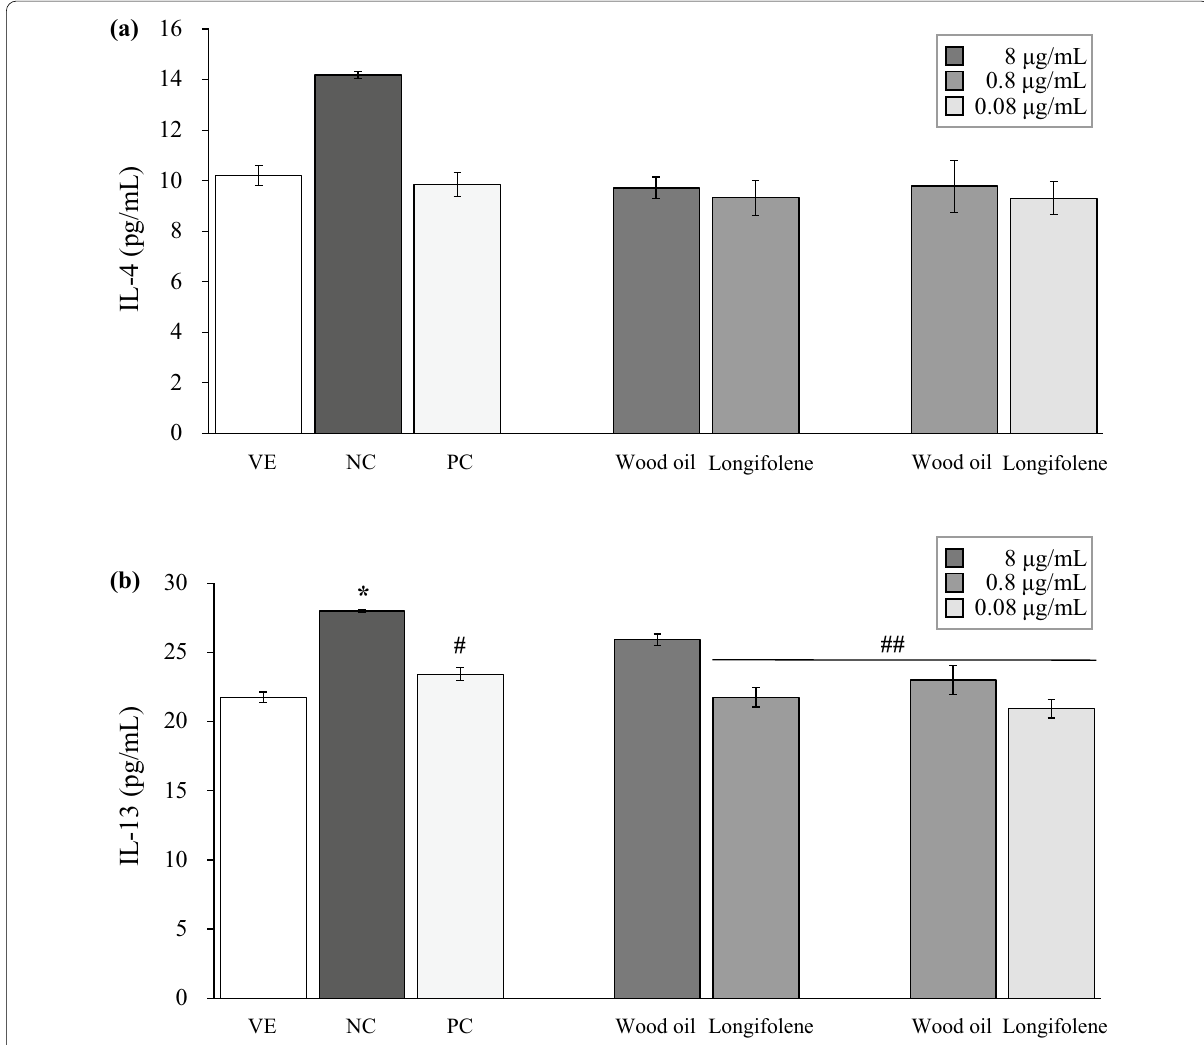
Fig. 9 Effect of longifolene on the protein expression levels of a IL‑4 and b IL‑13 in LPS‑stimulated RBL‑2H3 cells. VE: vehicle, DMSO; NC: negative control, 1 μg/mL LPS‑treated group; PC: positive control, 100 nM dexamethasone treated group. Values are presented as mean * p < 0.05 and ** p < 0.01 compared with VE; and # p < 0.05, ## p < 0.01 compared with